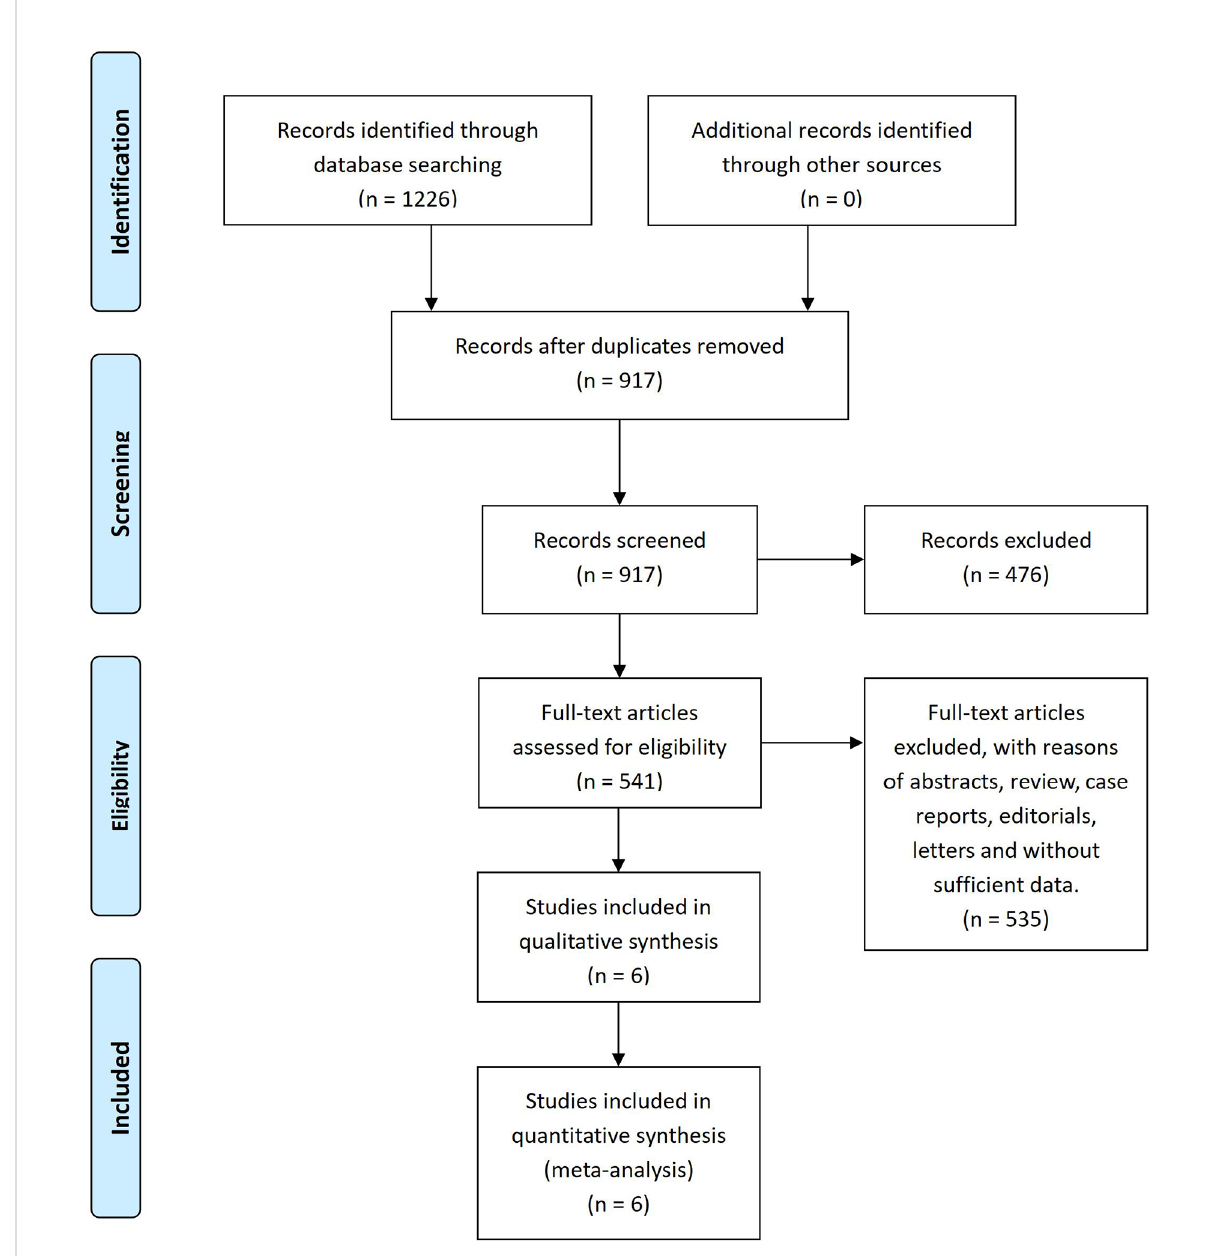
FIGURE 1 PRISMA fl ow diagram of the literature search and